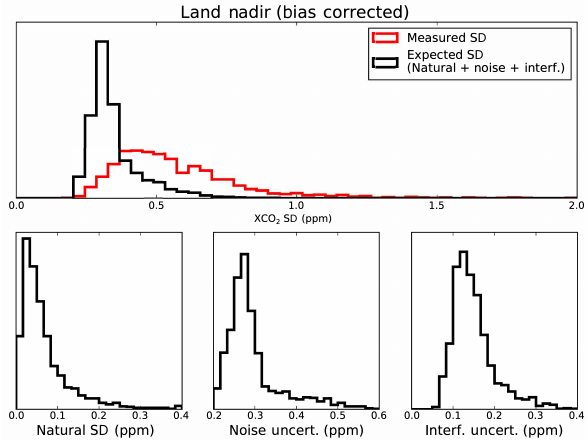
Figure A6. Same as Fig. A2 but for land-nadir